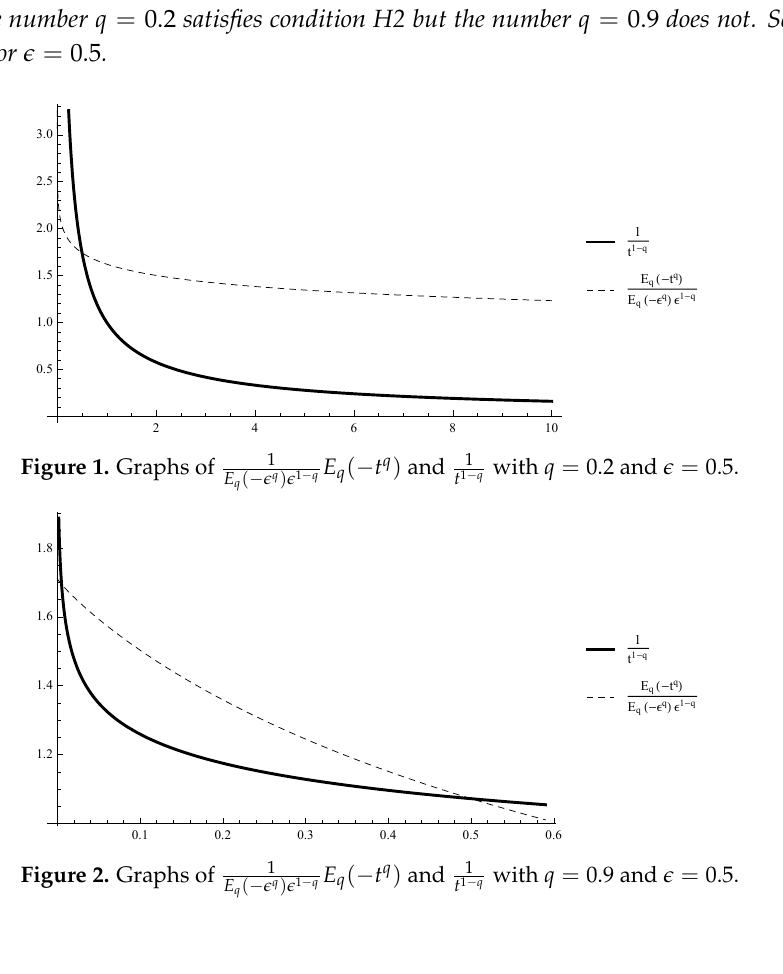
Figure 2. Graphs